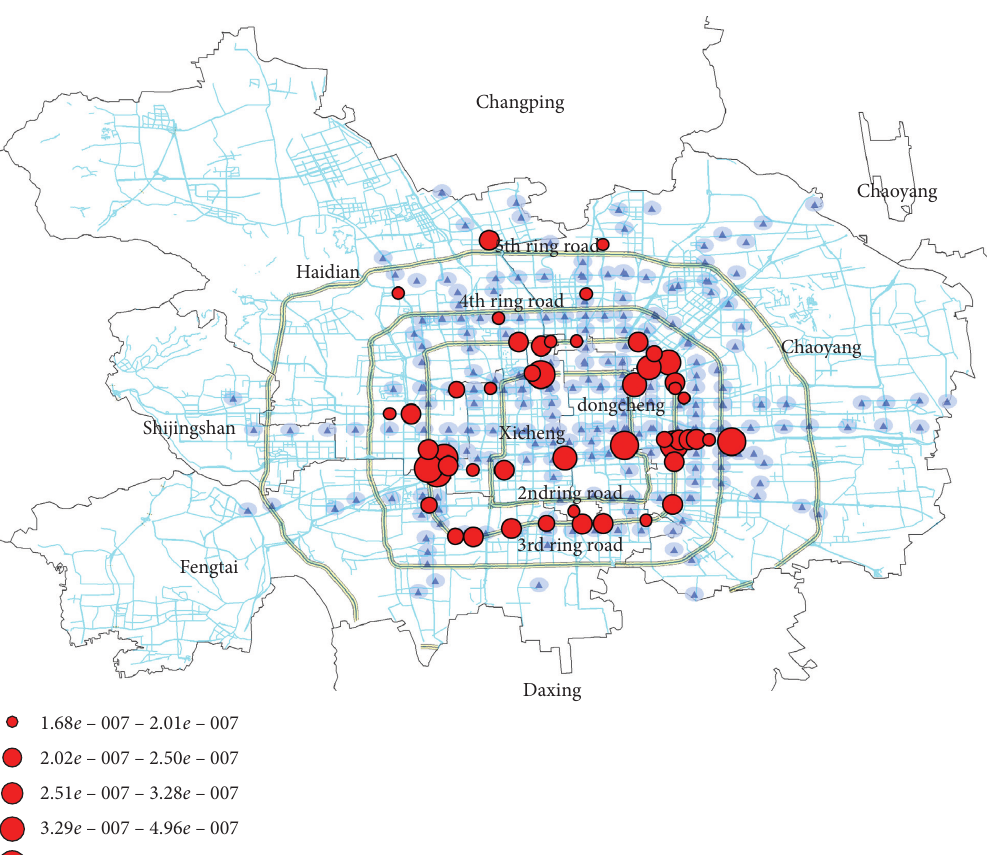
Figure 13: Key bus stations occupying the top 50 in off-peak (working